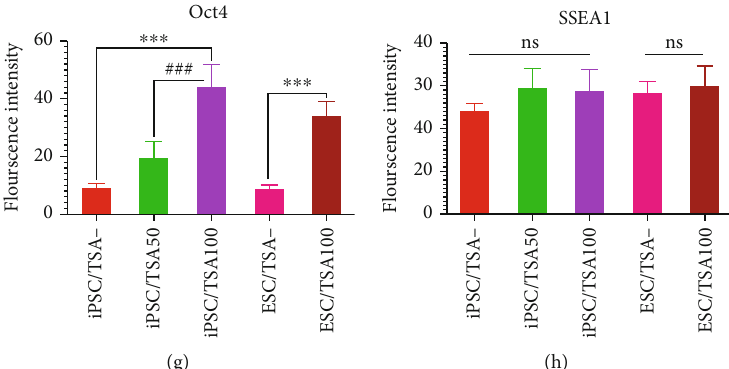
Figure 1: PSCs Characterization. (a) Schematic representation of study design. (b c) All emerged colonies (TSA-iPSCs, TSA+ iPSCs, IVF- ESCs, and TSA+ NT-ESCs) represented typical ESC-like morphology. (d) ALP activity in 100nM TSA-treated iPSCs (a), 50 nM TSA-treated iPScs (b), TSA-negative iPSCs (c), and ImageJ analysis showed 50nM and 100nM TSA concentration signi fi cantly increases the ALP expression in generated iPSCs (g). TSA treated ESCs (d), nontreated ESCs (e), and IVF-ESCs (f) all showed high ALP activity (h). (e) Normal karyotype of cell lines was con fi rmed by karyotyping. (f) The established PSCs express typical pluripotency markers, including OCT4 (green) and SSEA-1 (red). Nuclei were stained with DAPI (blue). (g, h) Fluorescent intensity of OCT4 and SSEA1 in iPSC and ESC colonies was quanti fi ed by ImageJ. ∗ indicates the statistical signi fi cance ( P < 0 : 05 ) compared to the control group. ∗∗∗ represents P < 0 : 001 .# indicates the statistical signi fi cance ( P < 0 : 05 ) between